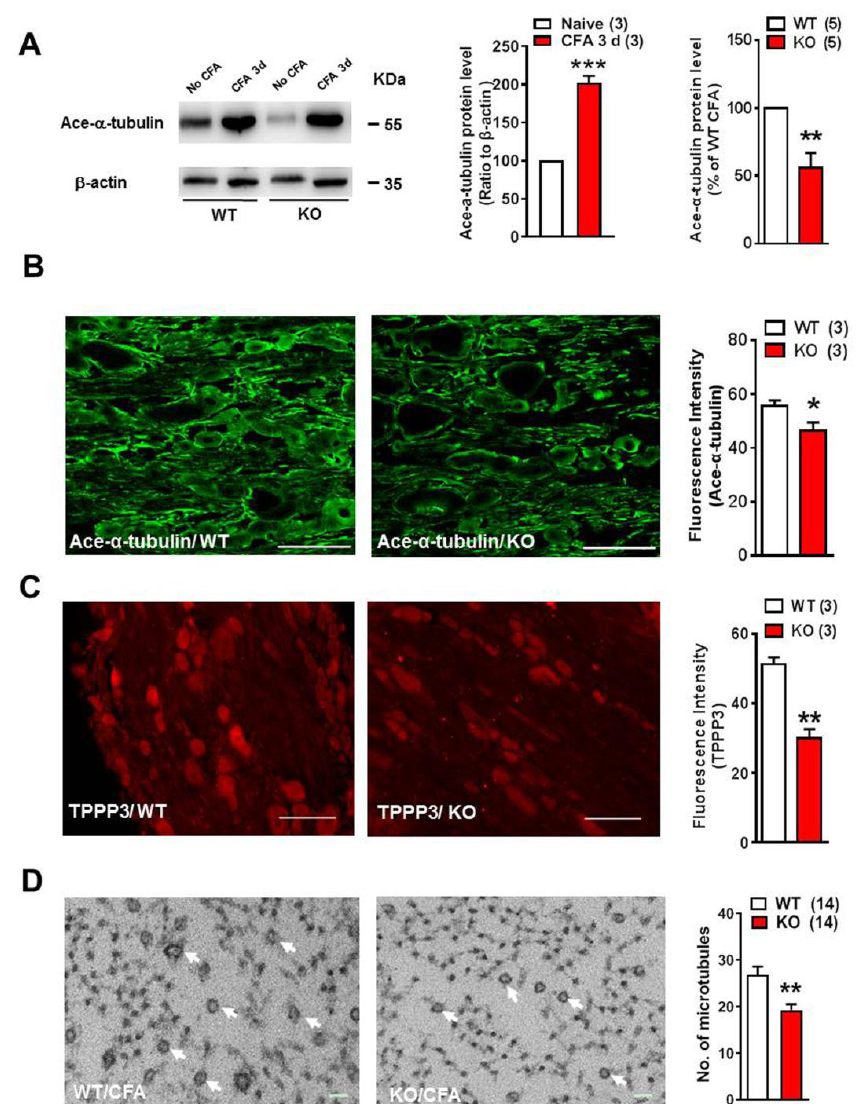
munohistochemical study showed that the fluorescence intensity of acetylated α -tubulin in DRG sections with CFA administration was decreased in Nogo-A KO rats when compared with WT ( n = 3, * p < 0.05) (Figure 2B). The level of TPPP3 protein was also reduced in KO rats 3 days after CFA treatment ( n = 3, ** p < 0.01) (Figure 2C). The reduction of microtubules in DRG neurons in Nogo-A KO rats was further confirmed using electron microscopy. The microtubule number in unmyelinated or thin myelinated fibers of DRG was significantly reduced in Nogo-A KO rats with CFA injection when compared with that of WT rats ( n = 3, ** p < 0.01) (Figure 2D).